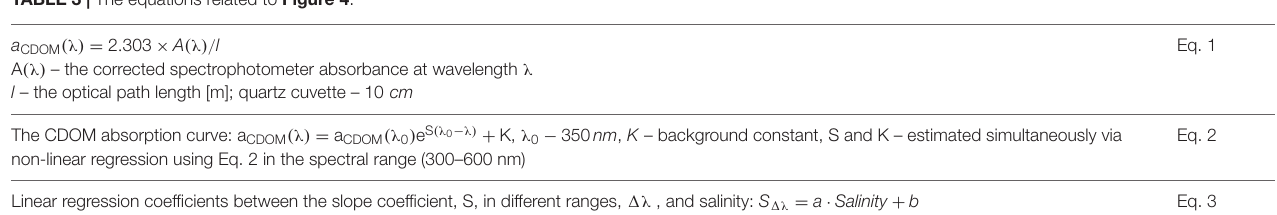
TABLE 3 | The equations related to Figure 4